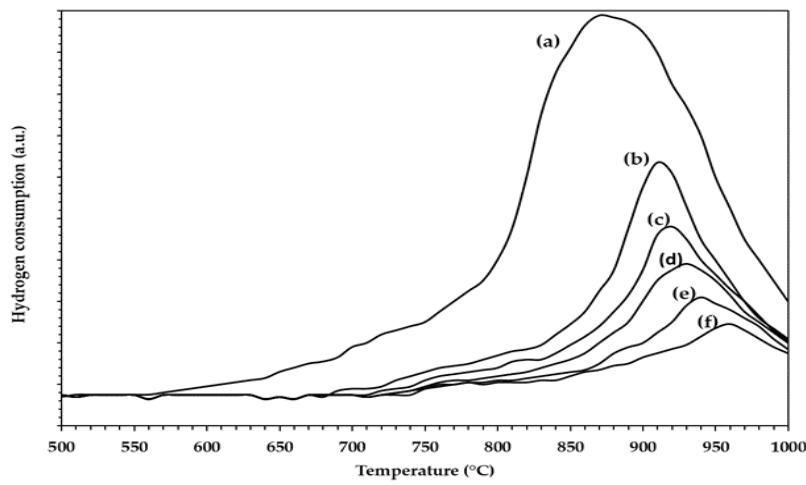
Figure 10. The TPR of SiO 2 -Al 2 O 3 -WO x microspheres: ( a ) 25SA‒16W, ( b ) 25SA‒8W, ( c ) 25SA‒4W, ( d ) 25SA-2W, ( e ) 25SA‒1W, and ( f ) 25SA‒0.5W.